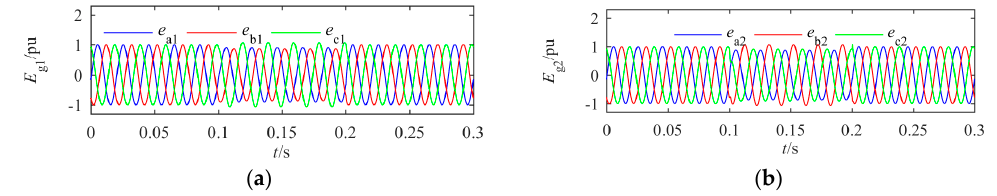
Figure 7. The grid voltage waveforms of the specified operating condition (SOC) for CS1 ( a ) and CS2 ( b ).